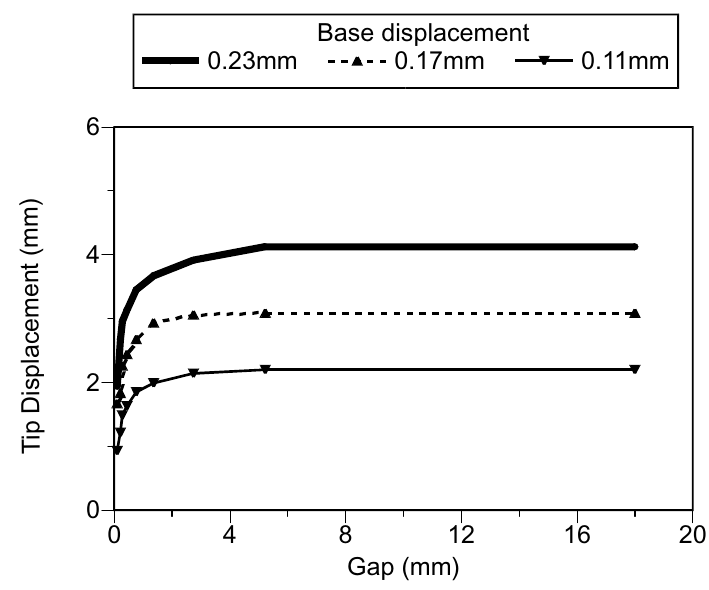
Fig. 10. Performance of beam/MCLD system gaps with base magnets and ferromagnetic constraining